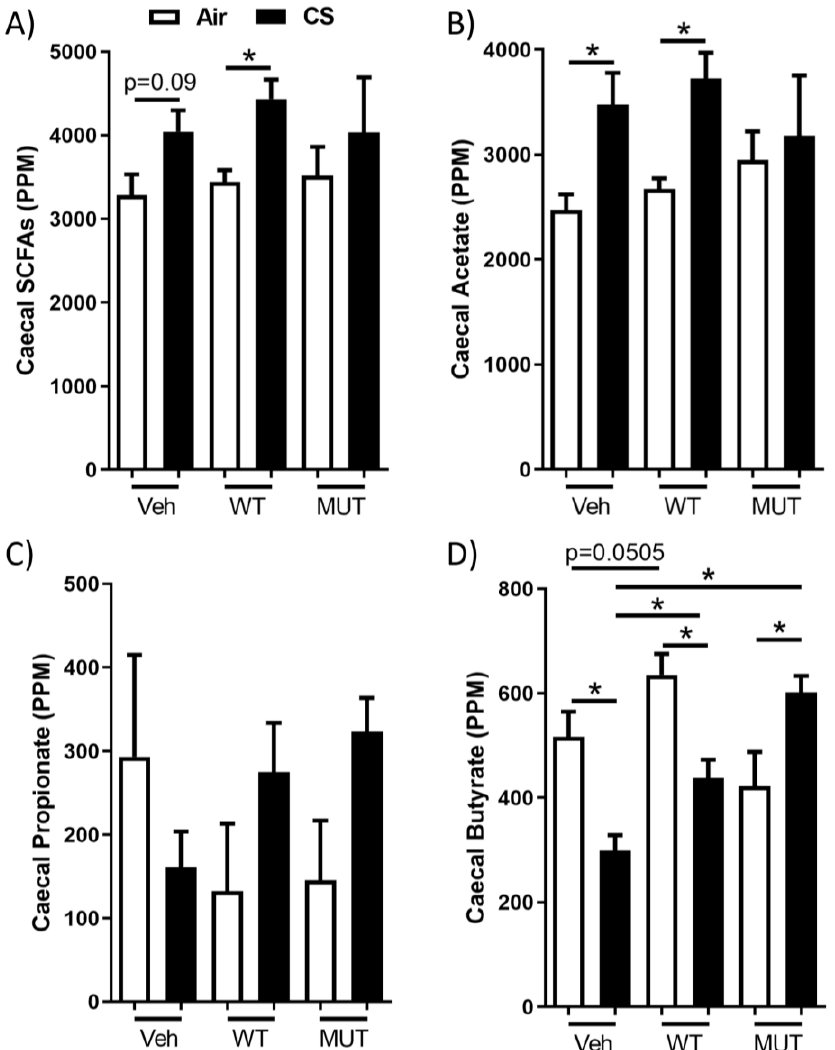
Figure 3. Probiotic Bifidobacterium longum subsp . longum protected against cigarette smoke-induced decreases in cecal butyrate. Mice treated with wild-type (WT) or mutant (MUTMUT) B. longum subsp . longum or vehicle (Veh) by oral gavage and were exposed to cigarette smoke (CS: black) or normal air (Air: white) for 8 weeks. ( A ) Total levels of short chain fatty acids (SCFAs), ( B ) acetate, ( C ) propionate, and ( D ) butyrate were quantified in cecal contents by gas chromatography. Data are presented as mean ± SEM. N = 5 – 6. * = p < 0.05.